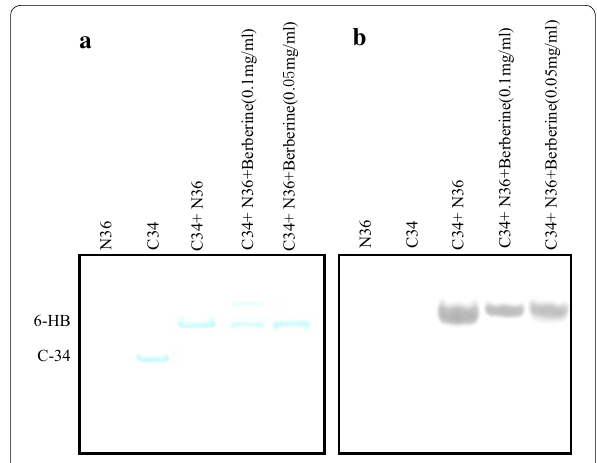
Fig. 2 a N-PAGE analysis for 6-HB formation by N36 and C34. The preincubated mixtures of the peptide N36 and berberine in phosphate-buffered saline (PBS) at the specified concentrations were added to C34, and then the peptides N36 or/and C34 with or without berberine were loaded into wells formed by combs in the gel s . N36 and C34 served as negative controls, C34 positive control. b The 6-HB structure formation by N36 and C34 was measured by Western blot using mAb